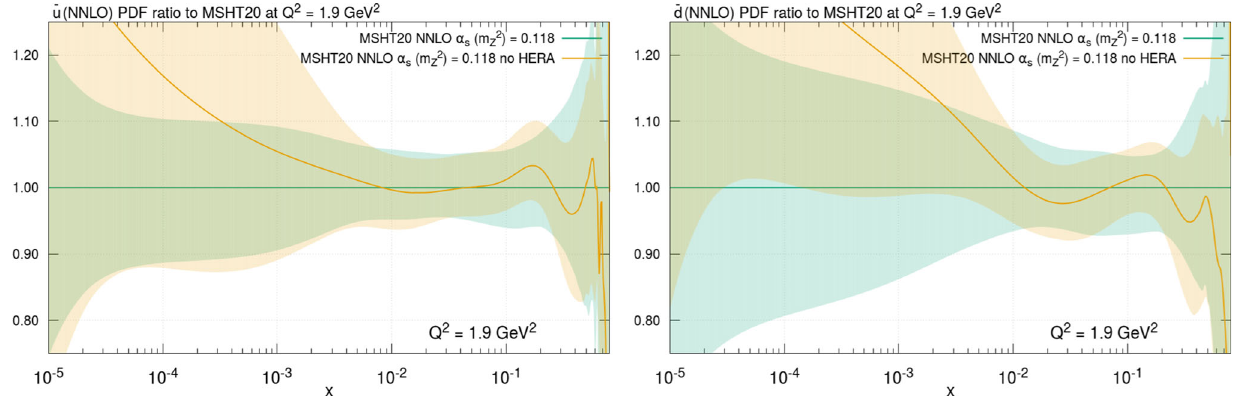
Fig. 73 (Left) ¯ u PDF and (right) ¯ d PDF ratios to the MSHT20 default at Q 2 = 1 . 9 GeV 2 at NNLO showing the effect of removing the HERA data from the MSHT20 default global